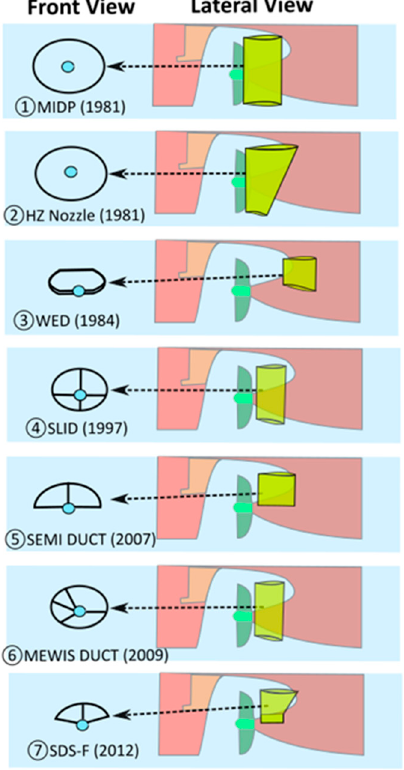
Figure 2. Pre-swirl ducts over the years.